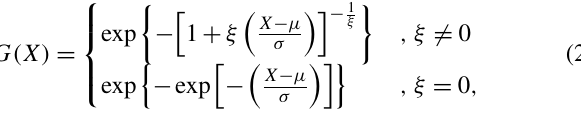
Figure 2. A comparison between model data with added χ 2 pling variability and observations that have been low-pass filtered by different methods. H s (f ) is the power spectrum of the signifi- cant wave height time series that has been multiplied by f 3 to ac- centuate shorter fluctuations. Data were from a coinciding ice-free period of 28 May 2011–1 February